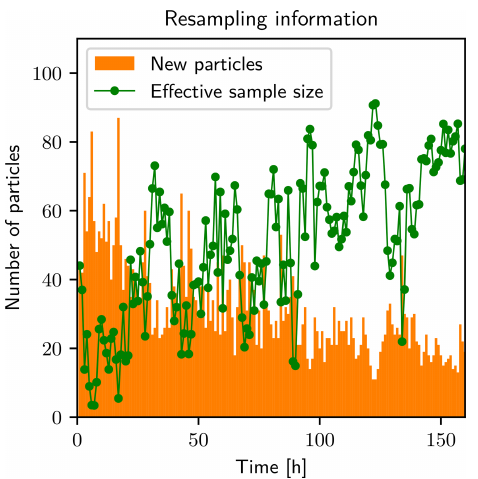
Figure 8. Amount of particles that are resampled (orange), and the effective sample size (green dots). The lines connecting the dots are for better visibility of the time-dependent behavior. The effec- tive sample size increases while the number of resampled particles decreases. Every infiltration reduces the effective sample size and leads to more resampled